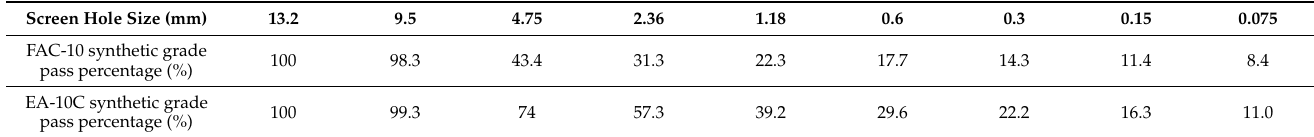
Table 4. Pavement layer FAC-10 synthetic grade.